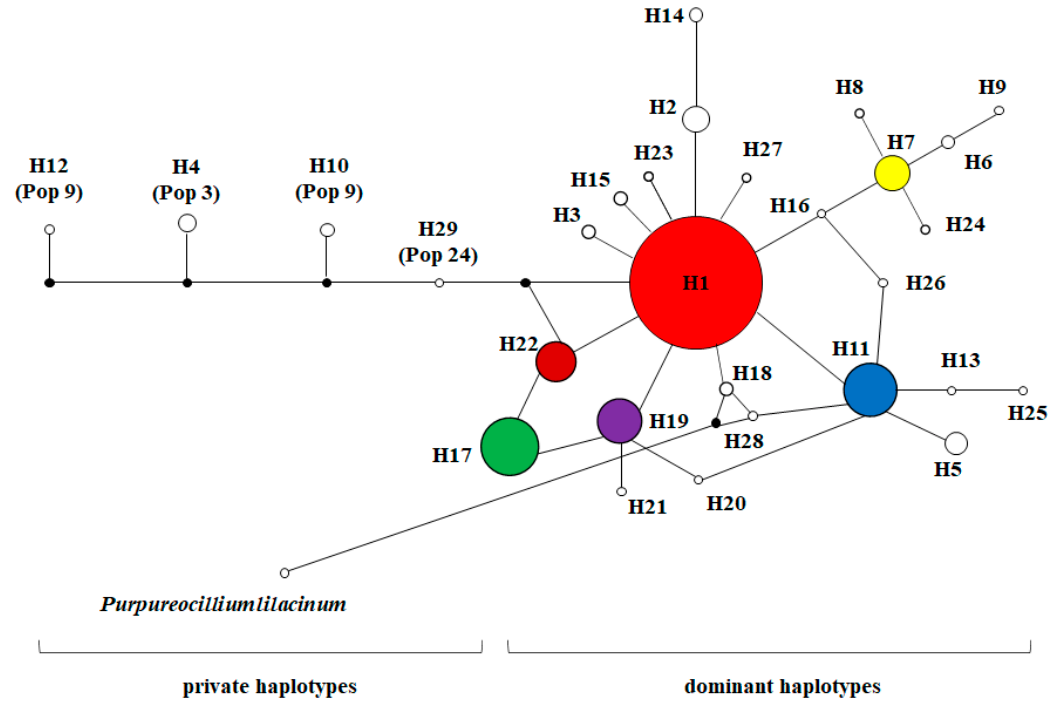
Figure 5. Phylogenetic network of NADPH-cytochrome P450 reductase-2 gene haplotypes of O. sinensis . Circle areas are proportional to haplotype frequencies. Circle colors are proportional to haplotypes defined in Figure 2. Purpureocillium lilacinum 36-1 (GenBank accession No. LCWV00000000.1) was used as an outgroup. Population codes correspond to those in Table S1.